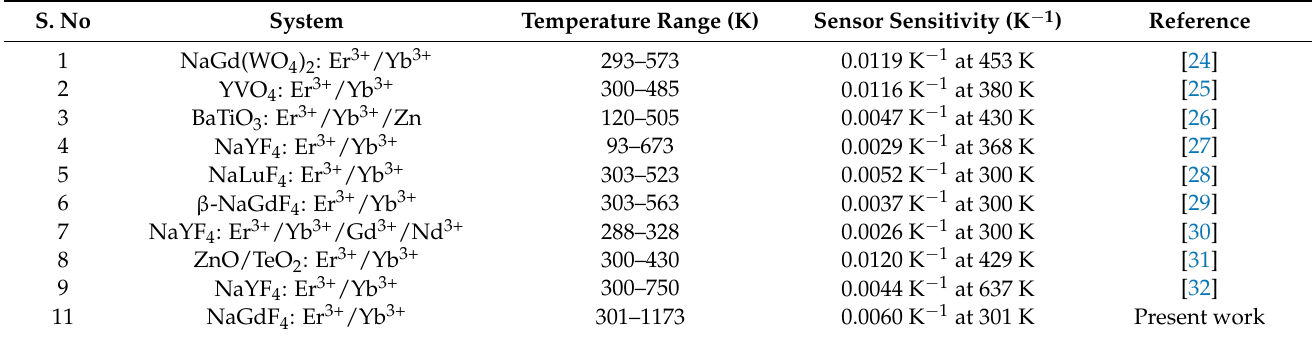
Table 1. Comparative results on temperature-sensing abilities of Er 3+ /Yb 3+ doped/co-doped